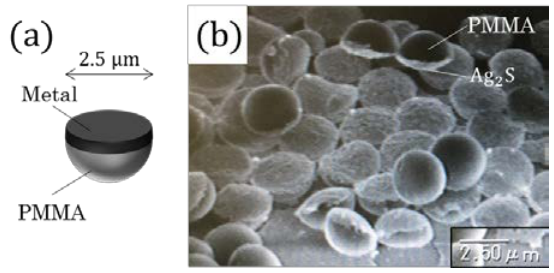
Figure 1. ( a ) The metal coated hemispherical Janus particle. ( b ) The scanning electron microscope (SEM) image of sulfurized silver on the equatorial plane of the hemispherical polymethylmethacrylate (PMMA) hemispherical particles. Silver is deposited only on the equatorial plane.